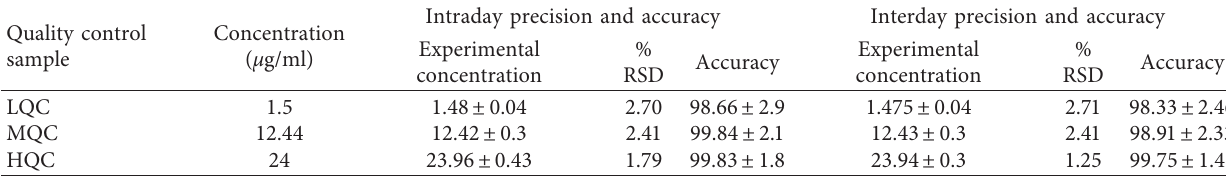
Table 5: Precision and accuracy of different quality control samples of ATS.